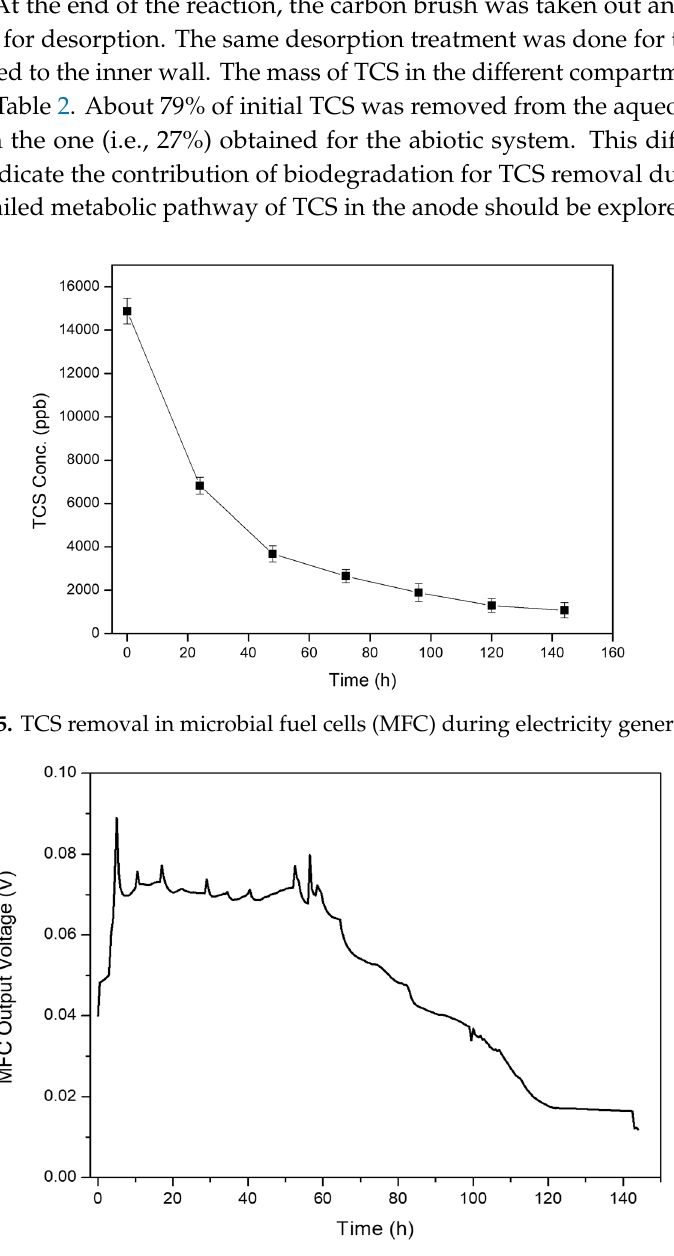
Figure 6. The electricity generation during bioelectrical treatment of TCS.